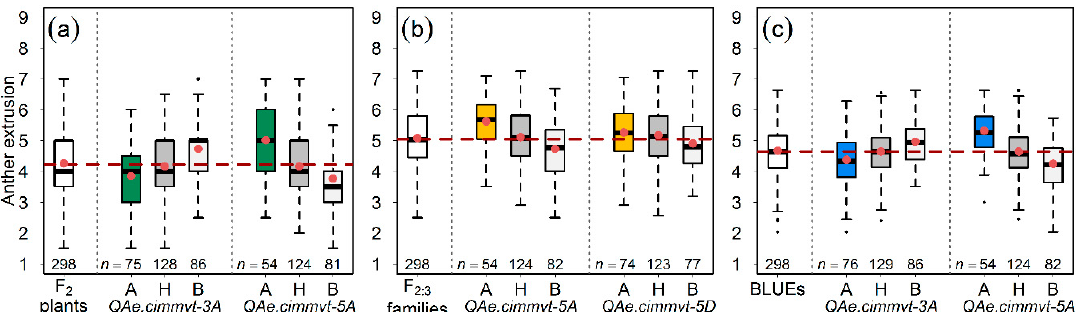
Figure 2. Allele-wise distribution of the most significant markers linked to the quantitative trait loci (QTL) for anther extrusion (AE). The QTL detected in ( a ) the population of F 2 plants, ( b ) the population of F 2:3 families, and, ( c ) best linear unbiased estimations (BLUEs) of F 2 and F 2:3 populations. A, B, and H represent the homozygous alleles from parent A, parent B, and heterozygous state, respectively. The dashed horizontal line marks the mean value of AE in the respective population. The red dots within the boxplots and n represent the mean of lines harboring respective alleles and the number of plants or families, respectively.